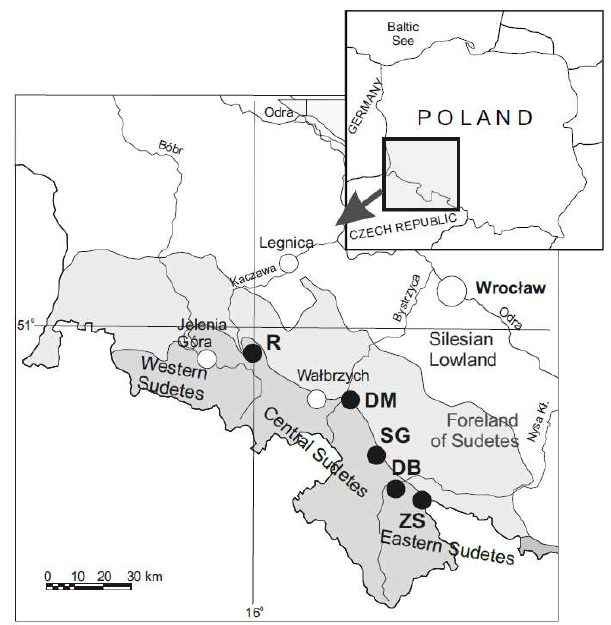
Figure 2. Location of sampling sites. For a closer description of geological settings and mining history see Karczewska et al. [50]. ZS: Złoty Stok; DB: Dębowina; DM: Dziećmorowice; R: Radzimowice; SG: Srebrna Góra.